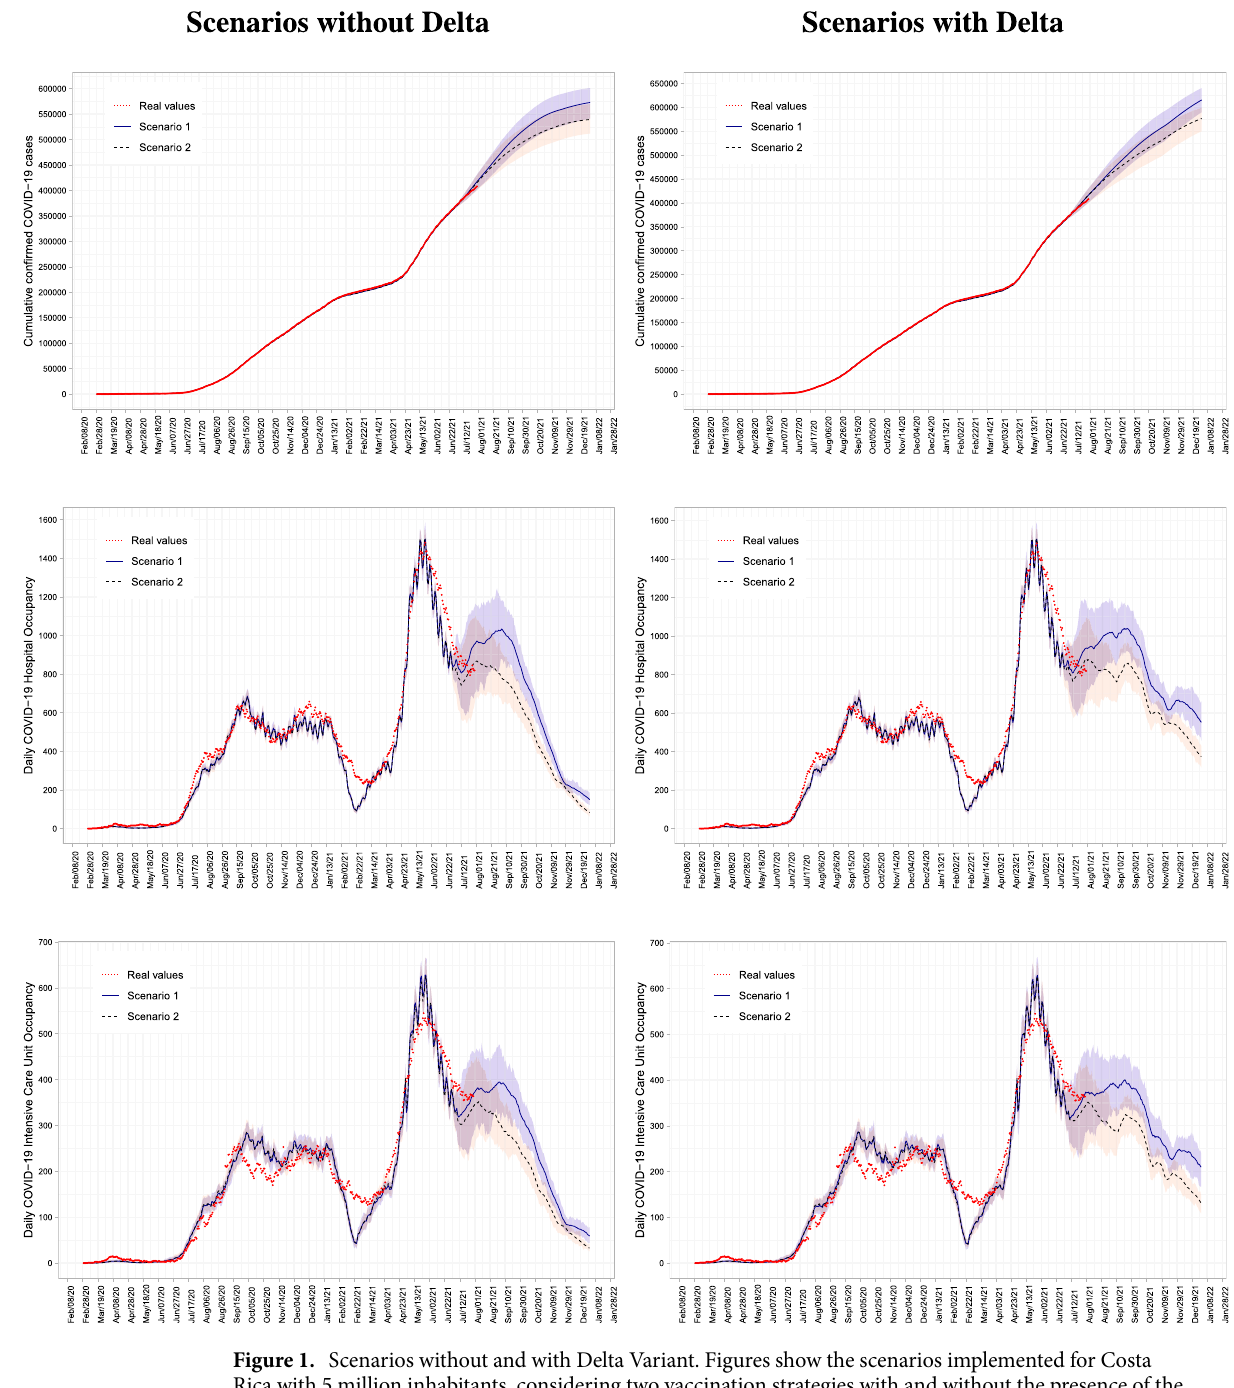
Figure 1. Scenarios without and with Delta Variant. Figures show the scenarios implemented for Costa Rica with 5 million inhabitants, considering two vaccination strategies with and without the presence of the Delta variant. Left panels correspond to the scenario without the introduction of Delta, and the right panels correspond to the results with the Delta variant. From top to bottom, cumulative Covid-19 confirmed cases, daily Covid-19 hospitalizations, and ICU Covid-19 occupancy. Projections are for the period from August 2 to December 31,